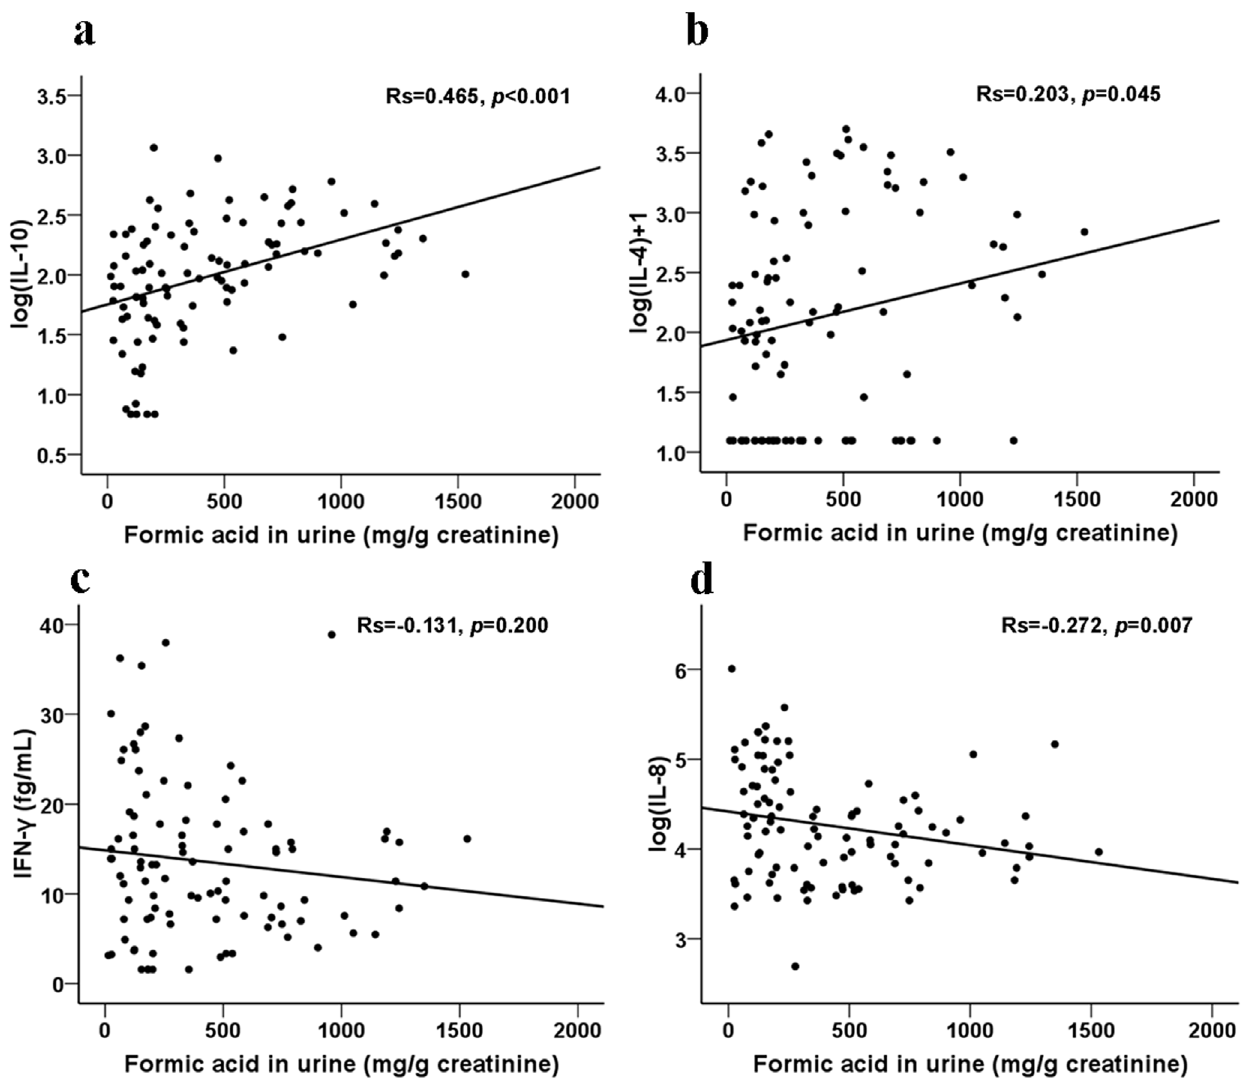
Figure 4. Correlation between formic acid and serum cytokine levels. Correlation between formic acid and IL-10 (a), IL-4 (b), IFN- c (c), or IL-8